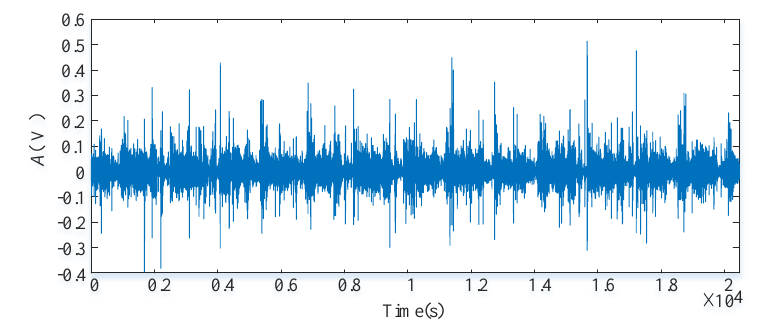
Figure 19. Test signal spectrum in the healthy condition.